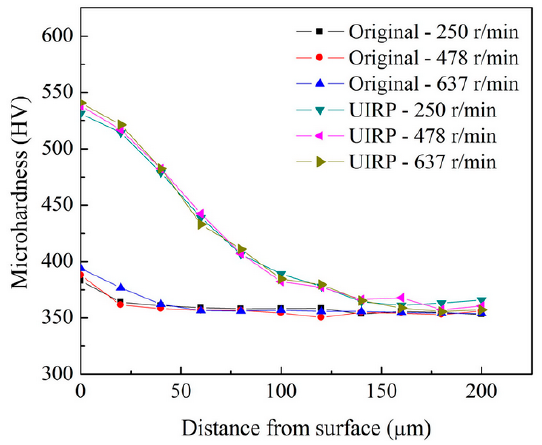
Figure 16. The cross section microhardness of UIRP and untreated samples after friction and wear tests.